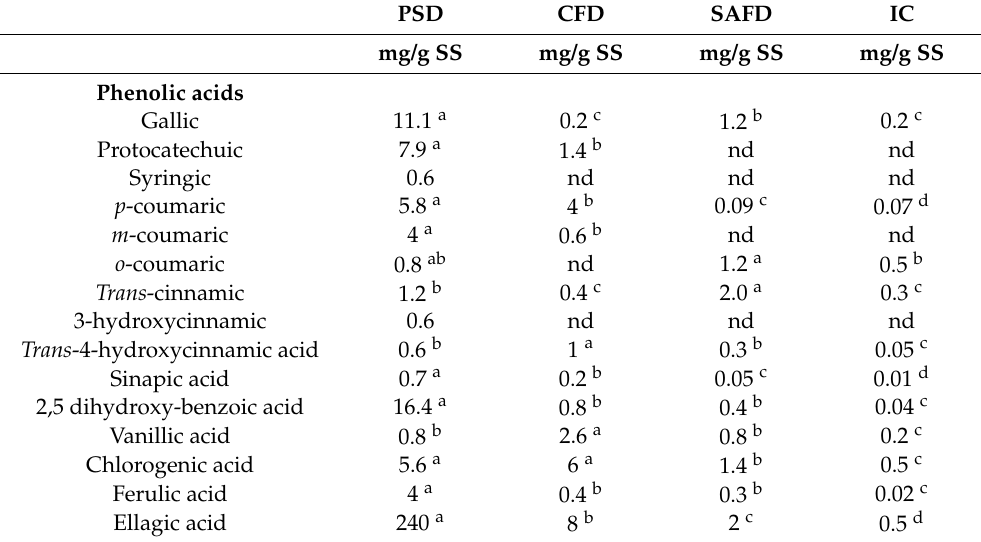
Table 1. Single phenolic acids contained in the peels of different pomegranate cultivars dried dif- ferently. PSD (spray-dried Wonderful peel, experimental data); CFD (Calabrian Wonderful peel freeze-dried, experimental data); SAFD (South African Wonderful peel freeze-dried, literature data); IC (Indian cultivar peel freeze-dried, literature data). The experimental data are the mean of six replicates. PSD CFD